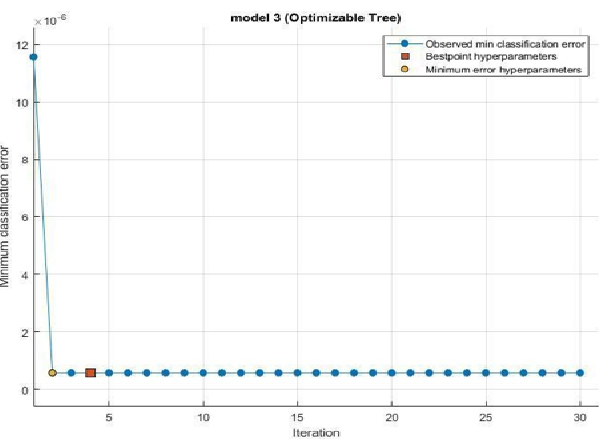
Fig. 25. SYN DOS minimum classification error of grid search based optimized tree